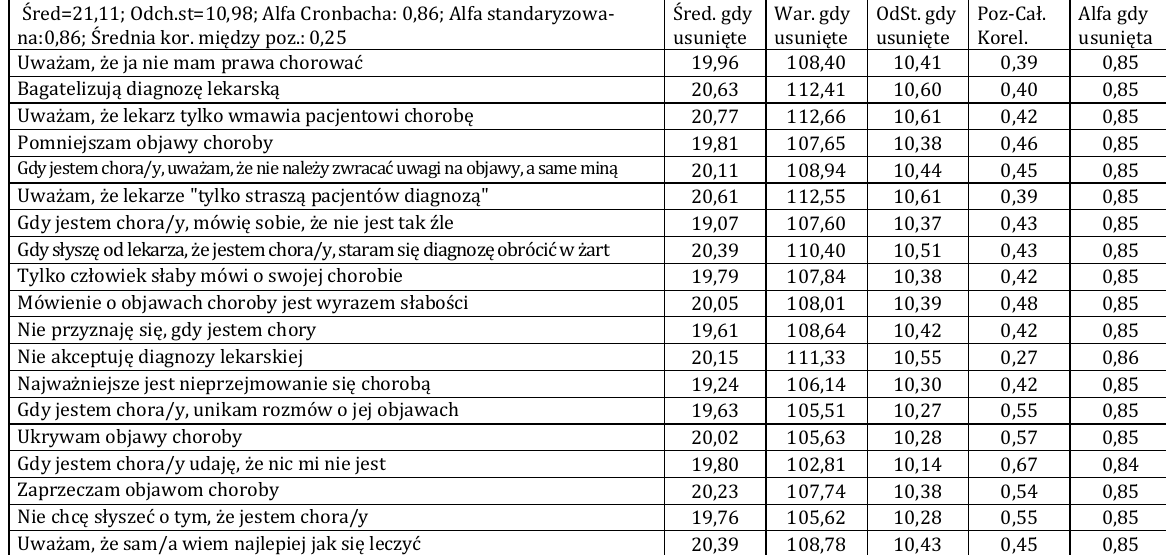
Tab. 3. Wyniki średnie, odchylenia standardowe oraz współczynniki rzetelności alfa Cronbacha dla całej skali oraz dla poszczególnych itemów tworzących skalę nazwaną – Choroba jako słabość Śred=21,11; Odch.st=10,98; Alfa Cronbacha: 0,86; Alfa standaryzowa- na:0,86; Średnia kor. między poz.: 0,25